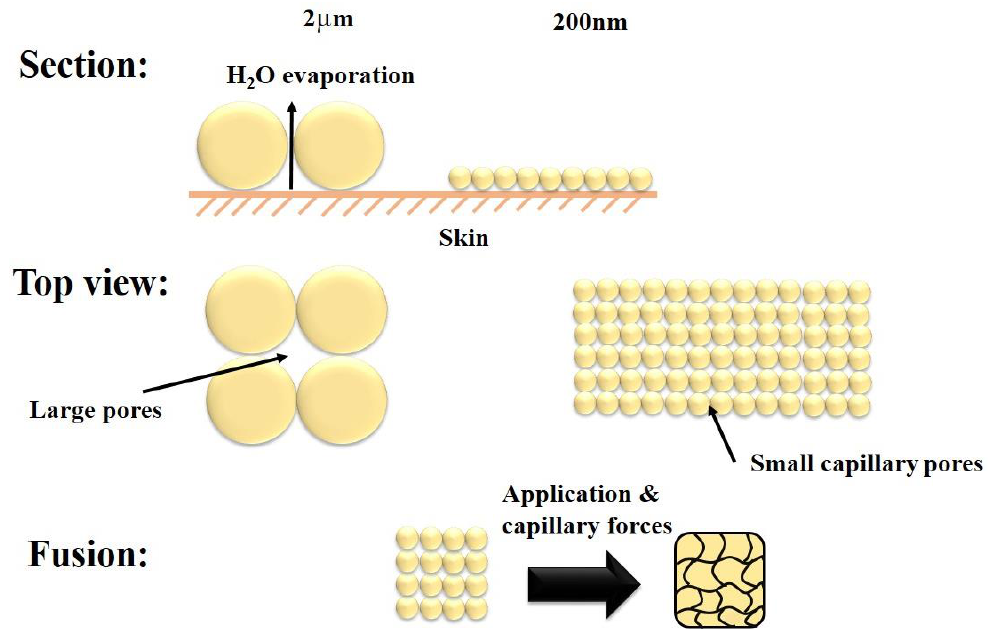
Fig. 6: Model of film formation on the skin for 2 mm and 200 nm lipid particles (in cross-section (top) and from above (middle)), a new model of nanoparticle fusion into a non-porous film (bottom).